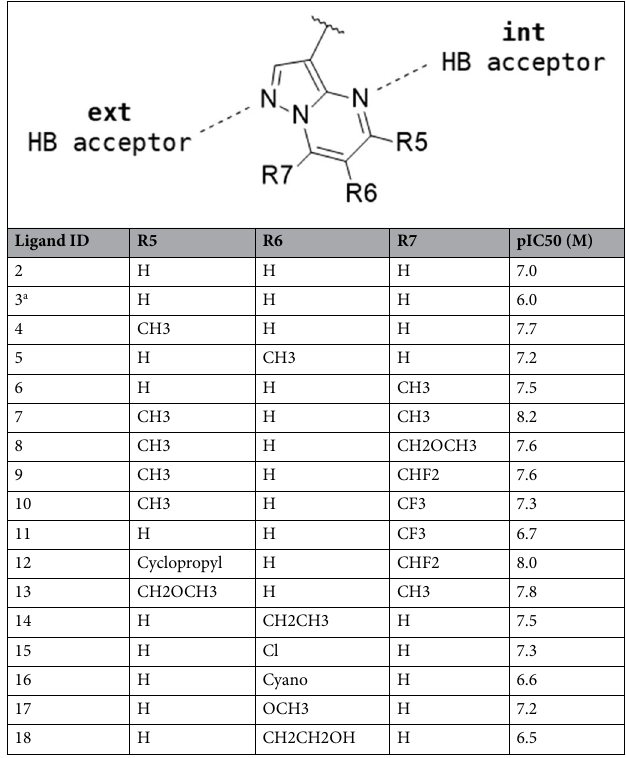
Table 4. The pyrazolopyrimidine scaffold shared across the selected ligands, their R1, R2, and R3 substituents, ligand identifiers and 11β-HSD1 pIC50s from Robb et al. The pyrazolopyrimidine scaffold also describes the intramolecular (int) and intermolecular (ext) hydrogen-bond acceptors. a The compound contains an imidazo- pyridazine scaffold, which is different to the others in the analysis but sufficiently similar to be included.